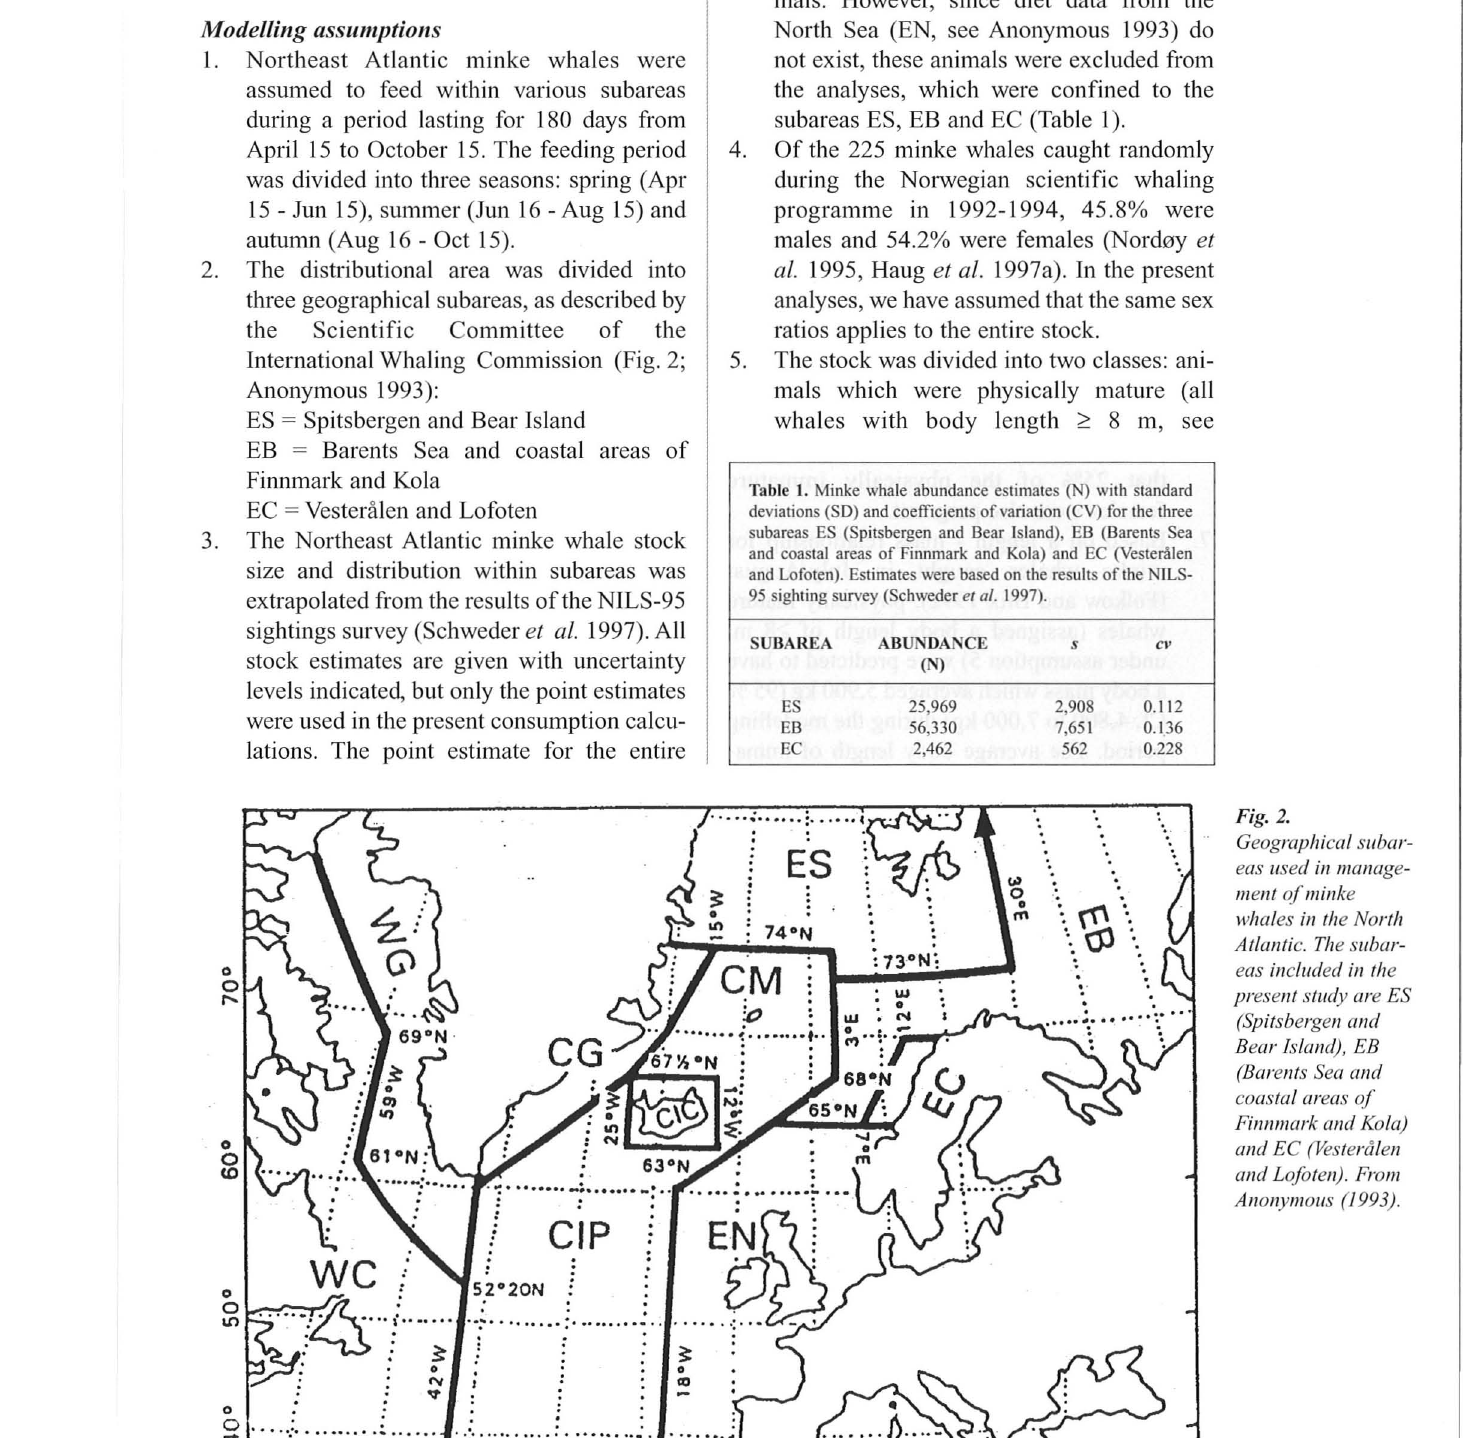
Fig. 2. Geographical subar eas lIsed ill II/allage II/ent oJlI/inke whales ill the North Atlantic. The subar eas included ill the present study are ES (Spitsbergen and Bear Is/alld), EB (Barents Sea and coastal areas oj Finllll/ark alld Kola) alld EC (Vestenllen alld LoJotell). Frail/ AllolIYlI/ous